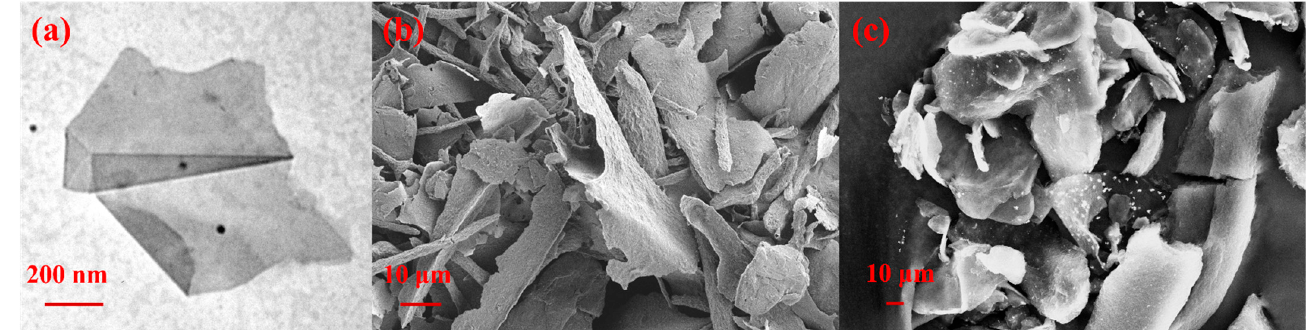
Figure 2. ( a ) TEM and ( b ) SEM micrographs of FFG; ( c ) SEM micrograph of Ag–FFG.